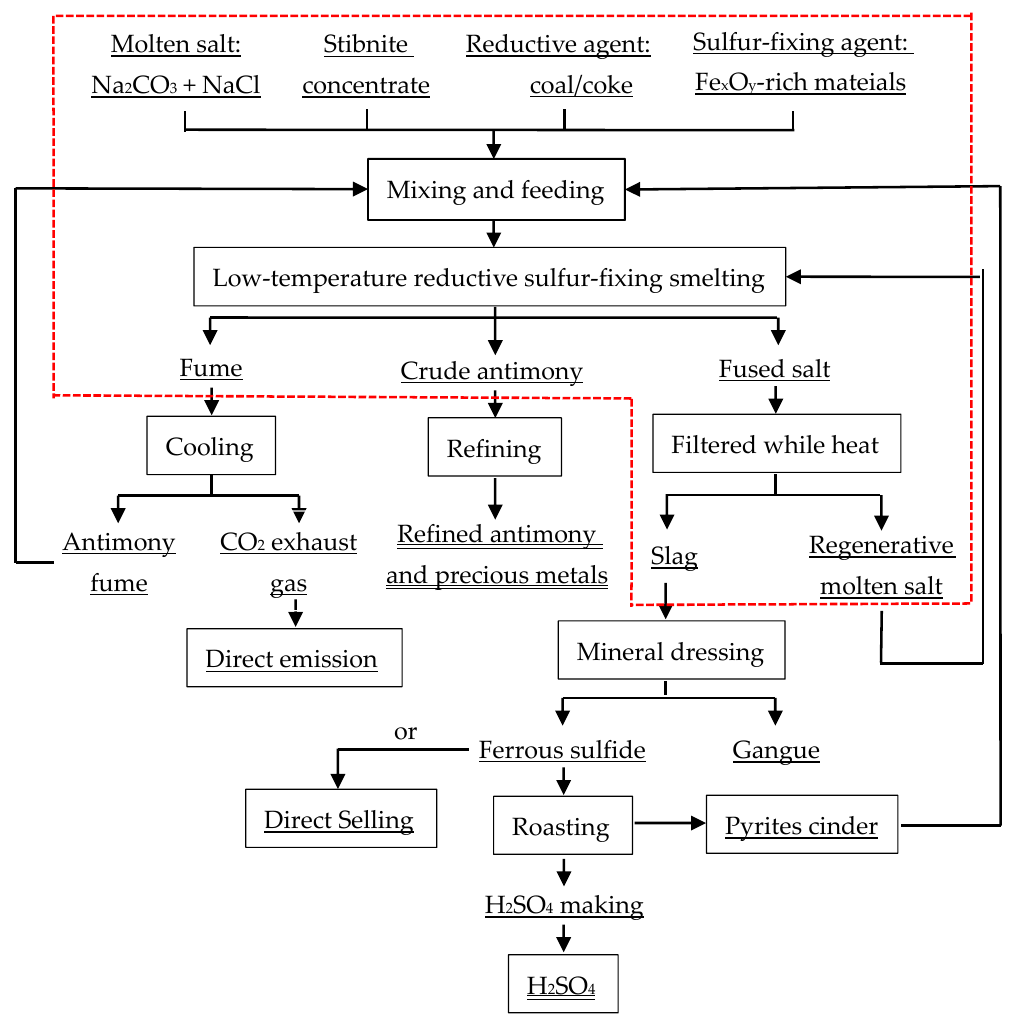
Figure 1. Flow sheet of reductive sulfur-fixing smelting of stibnite concentrate for one-step extraction of antimony in low temperature.